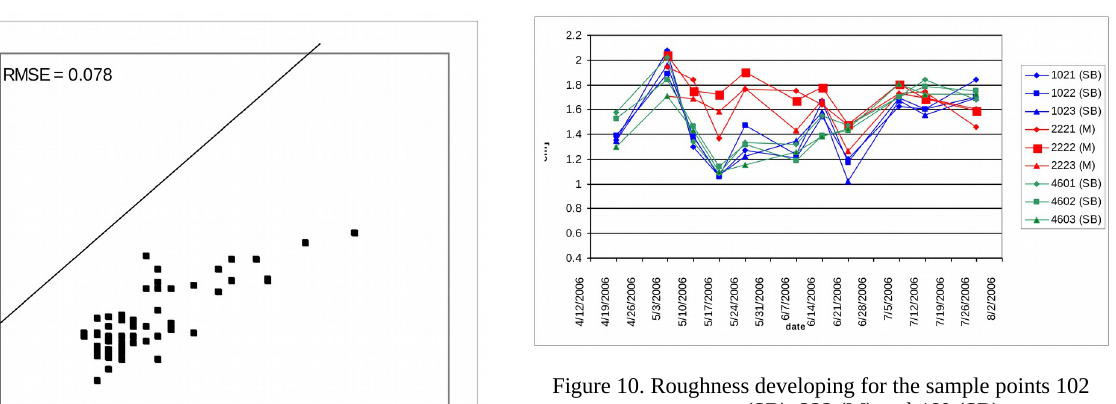
Figure 10. Roughness developing for the sample points 102 (SB), 222 (M) and 460 (SB) (101) the roughness decreases slightly. For Winterwheat and Winterbarley a stronger decrease of roughness can be observed until the 17 th of may. Than Winterwheat stays quite low (s=